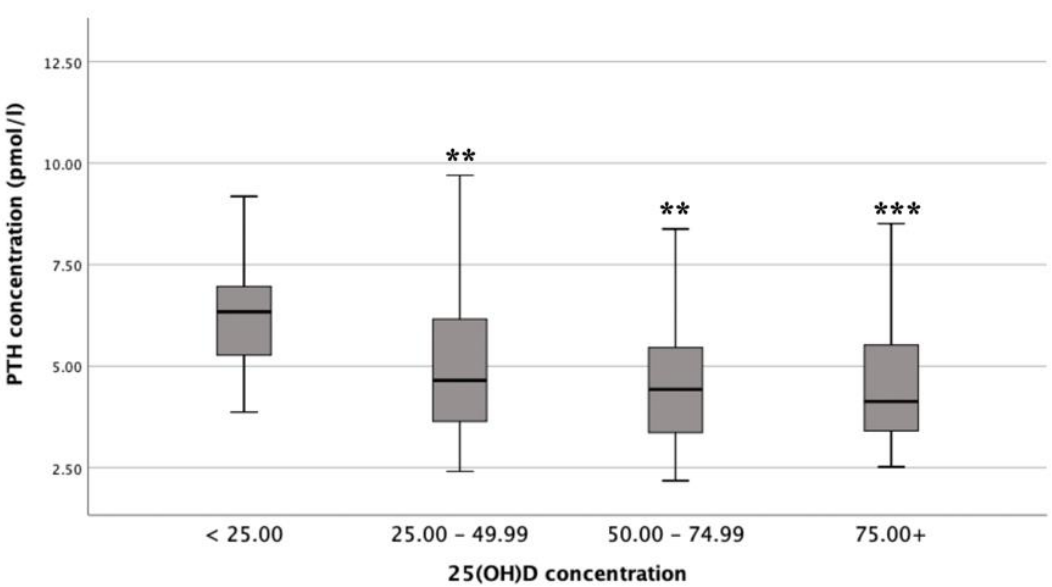
Figure 2. Di ff erences in mean parathyroid hormone (PTH) concentrations by di ff erent vitamin D status Figure 2. Differences in mean parathyroid hormone (PTH) concentrations by different vitamin D ( n = 135). ** p < 0.01; *** p < 0.001 (ANOVA compared to [25(OH)D] < 25 nmol / L). status ( n = 135). ** p < 0.01; *** p < 0.001 (ANOVA compared to [25(OH)D] < 25 nmol/L).